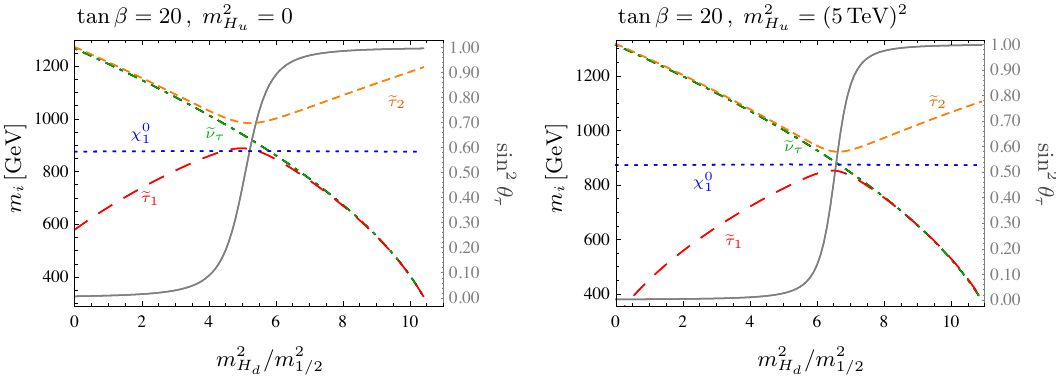
Figure 3 . Sparticle masses m (red long-dashed curve), m e (cid:28) 1 (green dot-dashed curve) and m (blue dotted curve) as a function of m 2 (cid:31) 0 1 of tan (cid:12) and m 2 . The stau mixing angle is indicated through the gray solid line showing sin 2 (cid:18) (cid:28) , H u labelled on the right